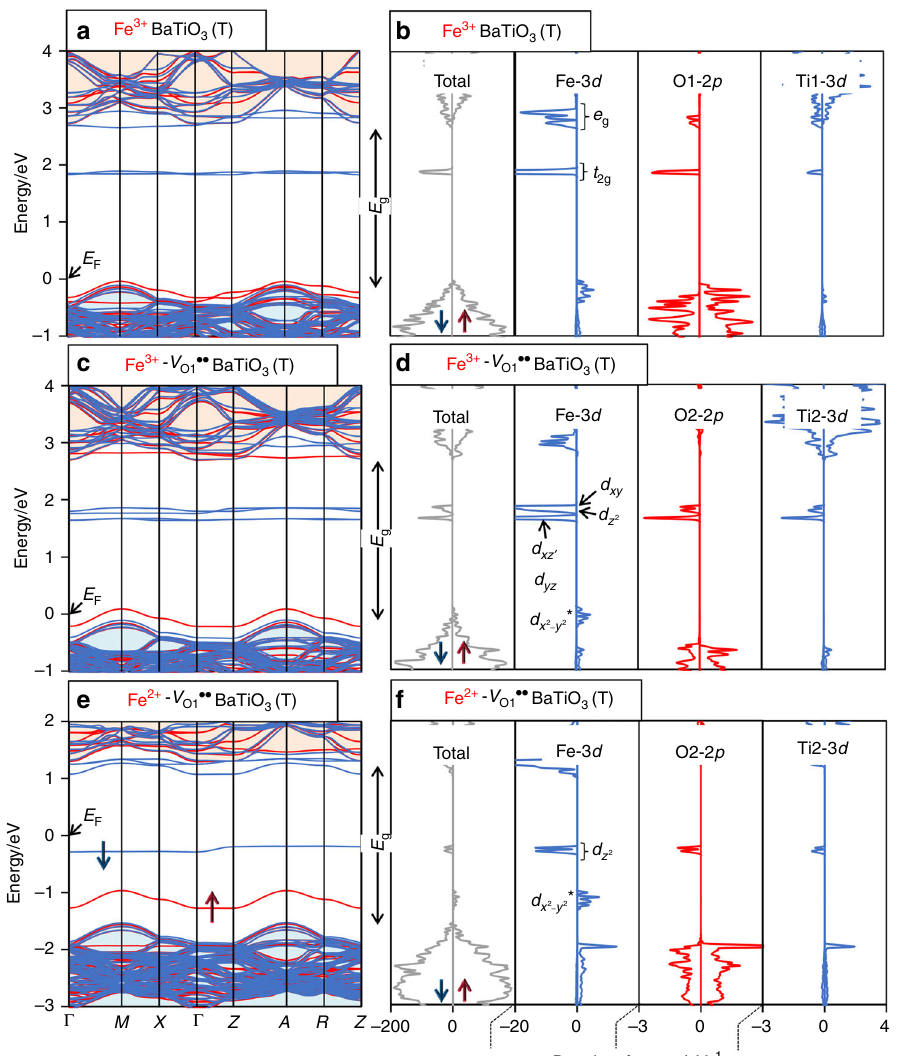
Fig. 4 Electronic structures of tetragonal (T) Fe-BaTiO 3 . Band structures and total (partial) density of states (DOS) for the a , b Fe 3 + , c , d Fe 3 + - V O1 (cid:129)(cid:129) , and e , f Fe 2 + - V O1 (cid:129)(cid:129) cells, where V O1 (cid:129)(cid:129) denotes the oxygen vacancy on the O1 site. The Fermi-level is indicated by E F . In the band structure, the red and blue lines represent the majority ( ↑ ) and minority ( ↓ ) spin components, respectively. The valence band and the conduction band of the host BaTiO 3 lattice are colored light blue and light orange, respectively. The bandgap is denoted by E g . The red and blue arrows in e represent electrons occupying in their corresponding spin bands. In the DOS, the right and left panels correspond to the ↑ and ↓ bands, respectively, as indicated in the total DOS. The Fe 3 + cell has the empty gap state of t 2g (bonding) in the ↓ band. In the Fe 3 + - V O (cid:129)(cid:129) and Fe 2 + - V O (cid:129)(cid:129) cells, the degeneracy of the d orbitals is lifted owing to the presence of V O (cid:129)(cid:129) . In the Fe 3 + - V O (cid:129)(cid:129) cell, four empty d ( ↓ ) states (bonding) appear near the middle of the bandgap. In the Fe 2 + - V O (cid:129)(cid:129) cell, the electron- occupied d x 2 (cid:3) y 2 (cid:1) ( ↑ ) state is above the valence band maximum (VBM) (asterisk denotes antibonding), and the E F is formed near the middle of the bandgap by the occupied d z 2 ( ↓ ) state